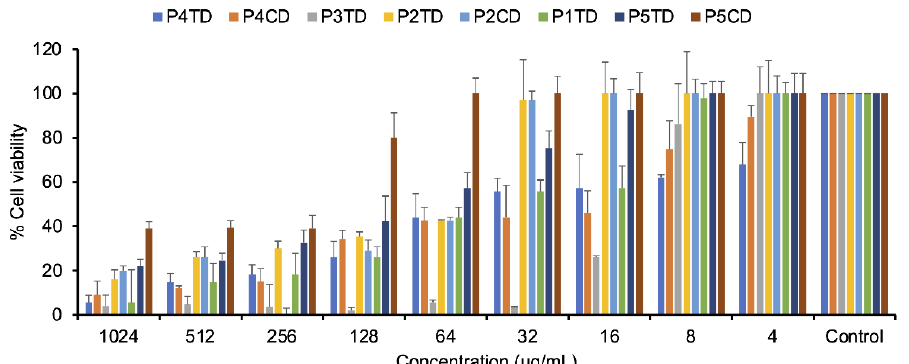
Figure 11. Cell viability of human gingival fibroblast cells was determined after 24 h of incubation with polymers P1TD, P2CD, P2TD, P3TD, P4CD, P4TD, P5CD, and P5TD, by the MTT assay. Standard deviation is plotted with error bars in the graph. Control conditions implied no polymer added.